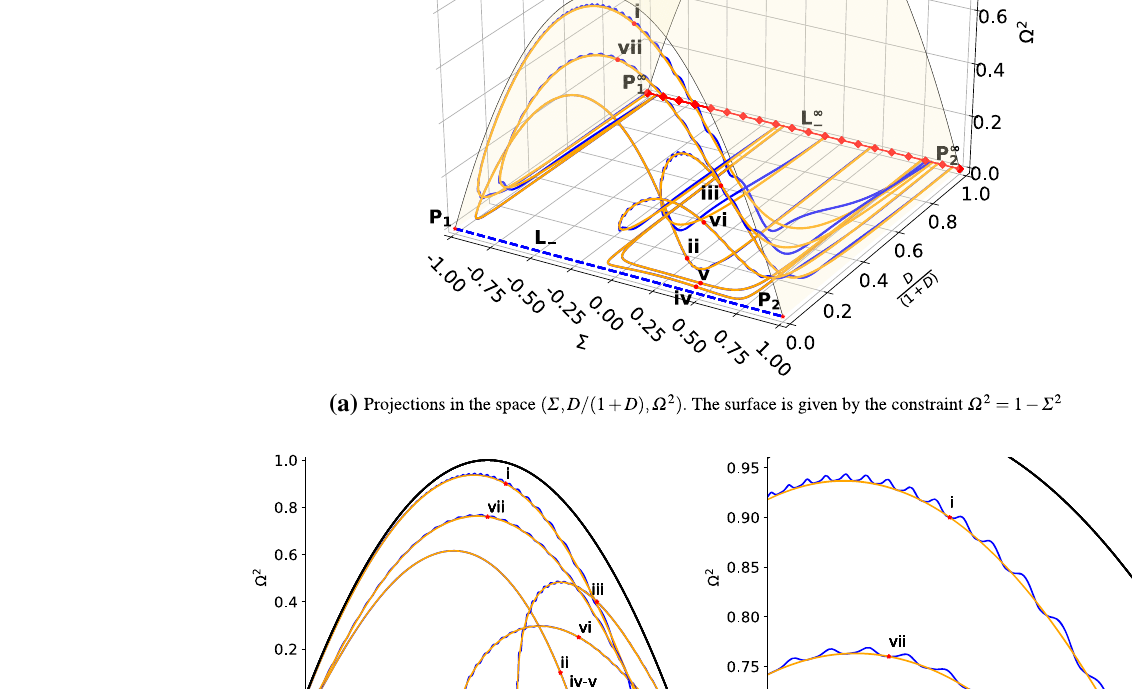
Fig. 19 Some solutions of the full system (93) (blue) and time-averaged system (127) (orange) for the KS metric when γ = 2 in the projection Q =